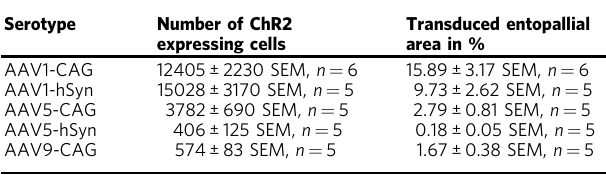
For all serotypes, the mean number of ChR2 expressing cells and the mean ChR2 expressing entopallial area in % was assessed for at least fi ve injections into separate hemispheres of at least three